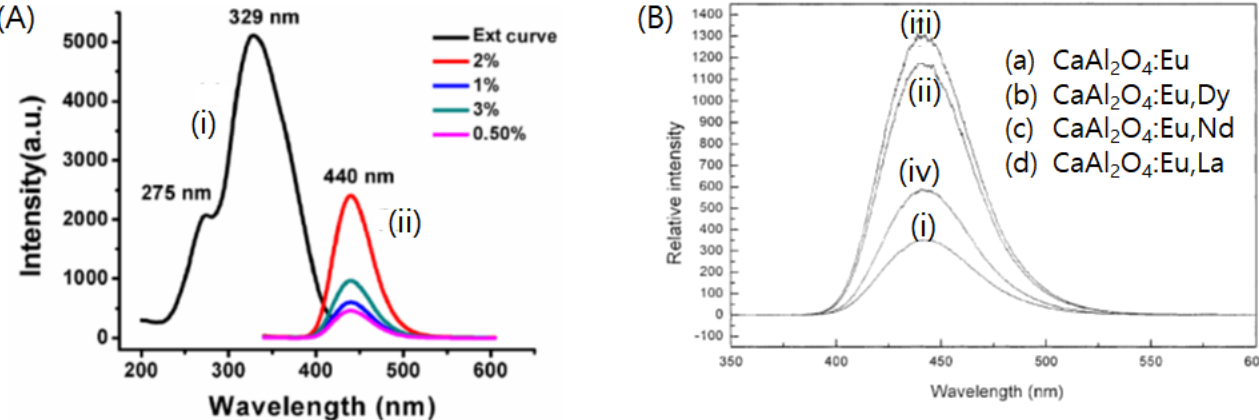
Figure 3. Photoluminescence spectra for lanthanide doped calcium aluminate phosphors ( A ) Photoluminescence excitation (i) and emission (ii) spectra for CaAl 2 O 4 :Eu 2+ . Adapted from Ref. [30] under Creative Commons Attribution (CC BY) license. ( B ) Emission spectra of (i) CaAl 2 O 4 :Eu 2+ , (ii) CaAl 2 O 4 :Eu 2+ ,Dy 3+ , (iii) CaAl 2 O 4 :Eu 2+ ,Nd 3+ , (iv) CaAl 2 O 4 :Eu 2+ ,La 3+ . Adapted with permission from [82] . Copyright Elsevier, 2003.